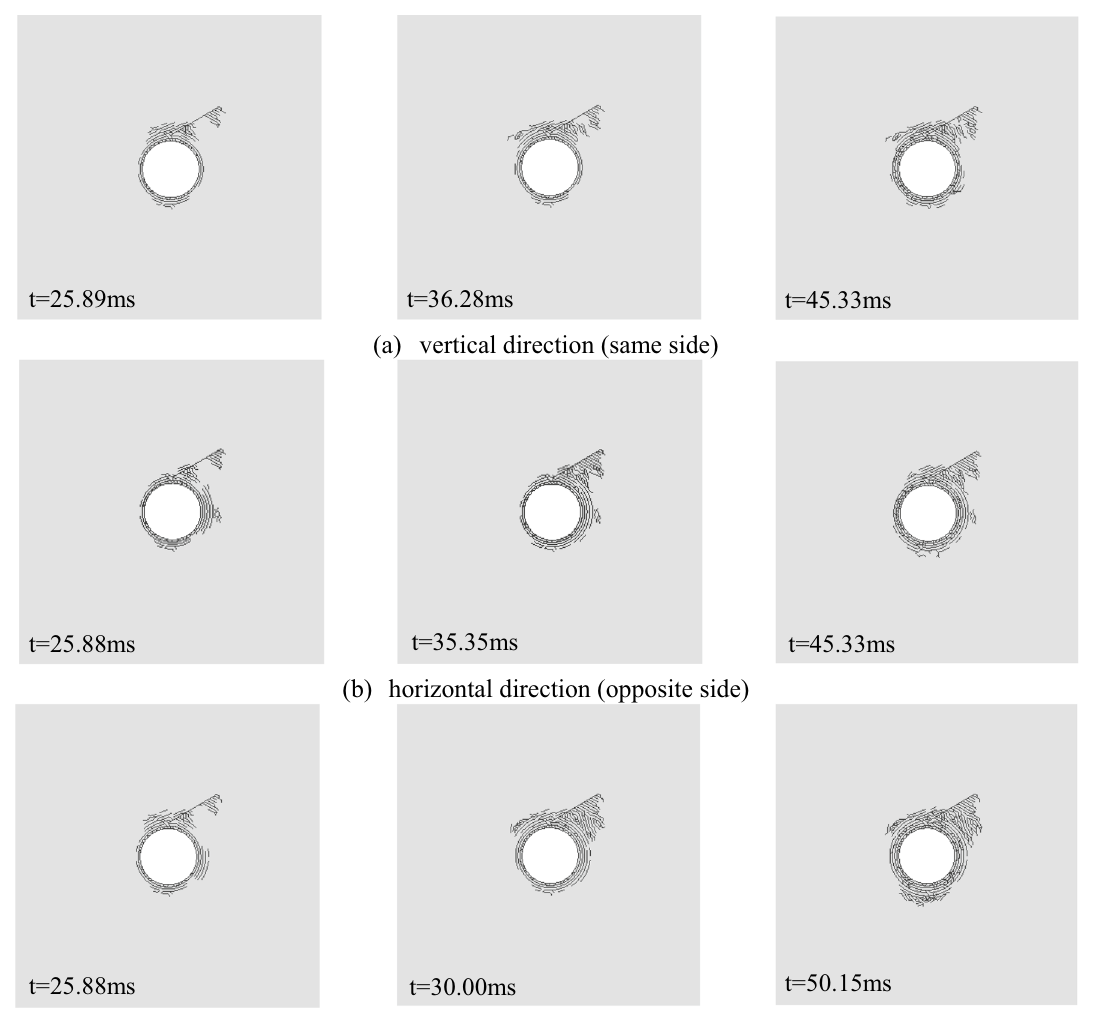
Fig. 19 Final failure mode of circular cavern with a nearby structural plane at a dip angle of 30° subjected to external dynamic disturbances with various directions. Note: The initial time in this figure starts from t = 2.5